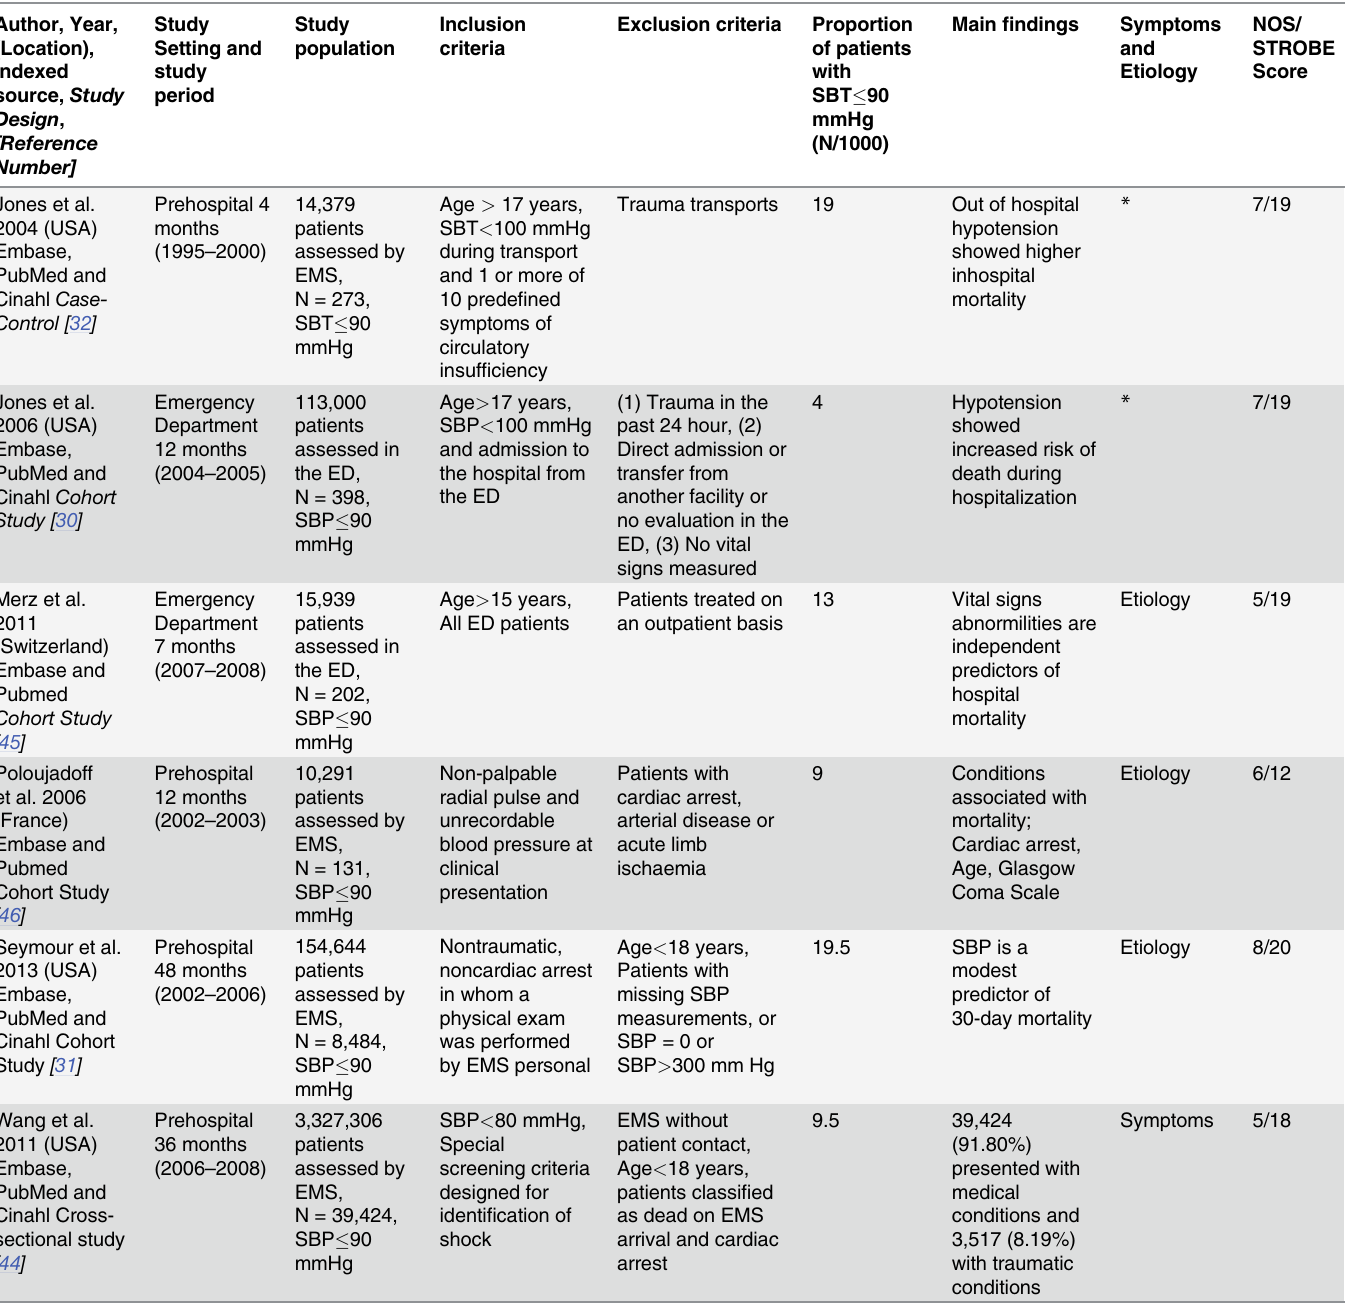
Table 1. Characteristics of included